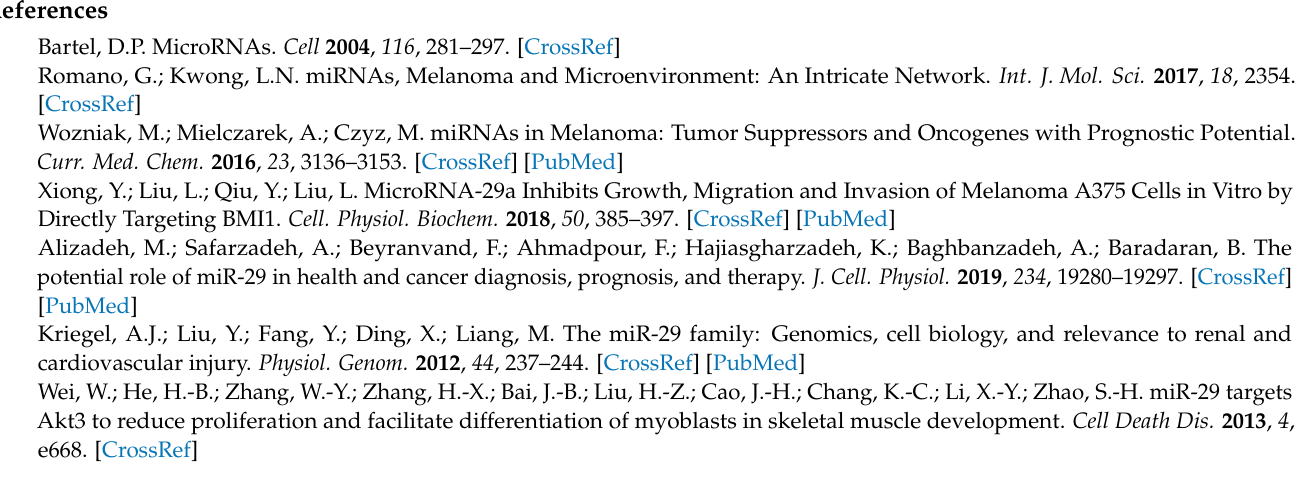
Table S2: List of primers and reagents used in this manuscript, Data S1: Supplementary